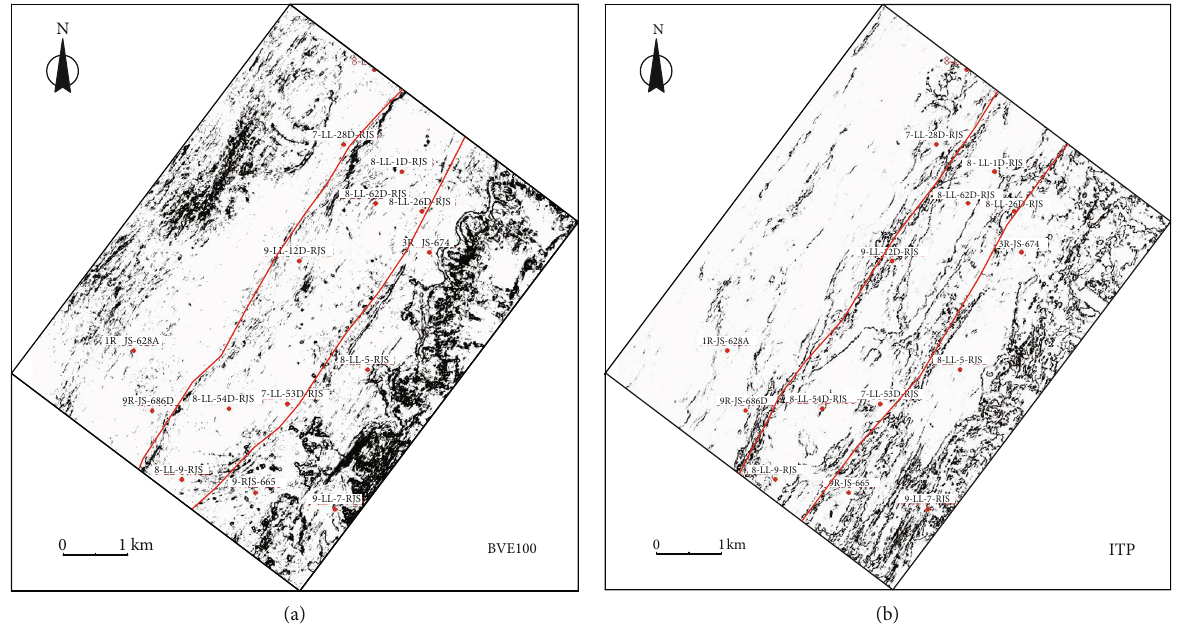
Figure 18: Seismic fracture detection results of the BVE100 and ITP layers.